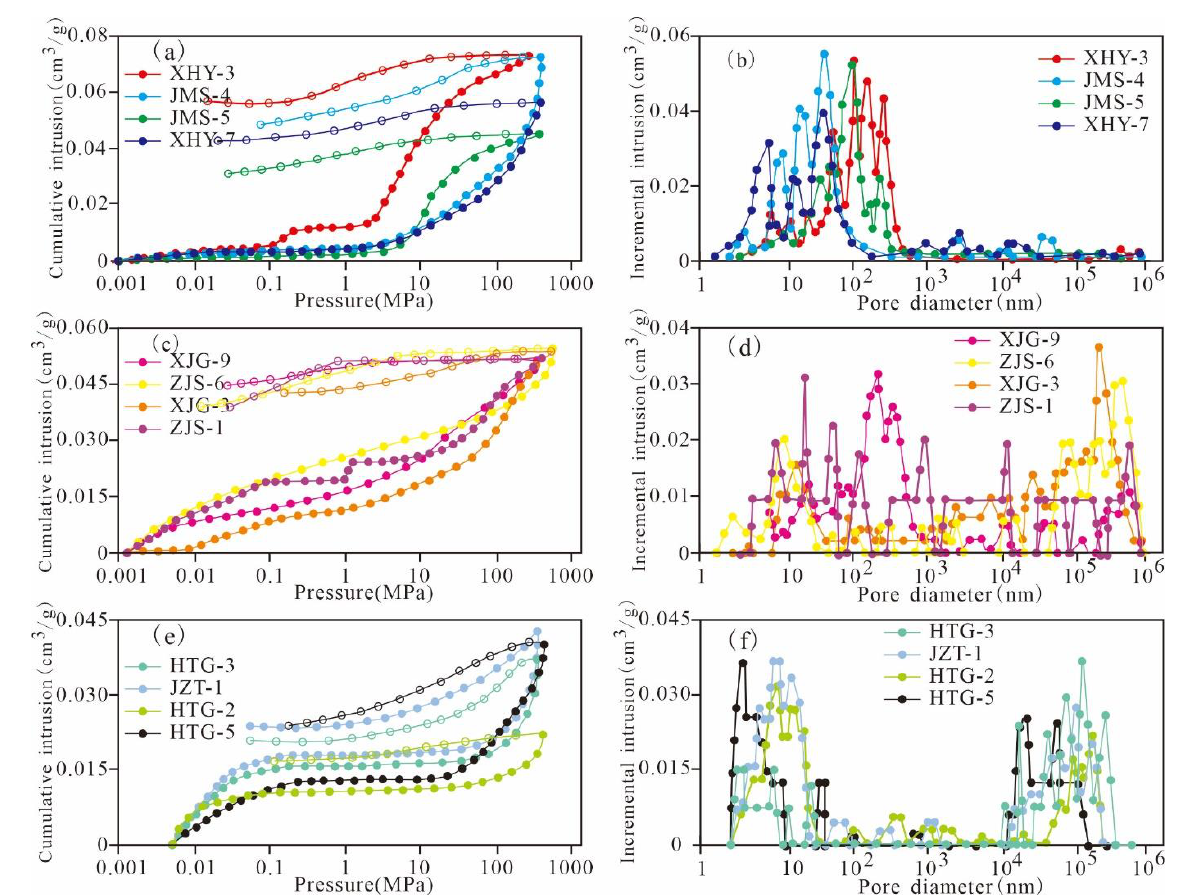
Figure 2. Mercury intrusion curve characteristics and pore type classification of Mesoproterozoic Xiamaling shale samples in Zhangjiakou, Hebei.4.3. Mesopore and micropore characterization based on gas adsorption. ( a , b ): the first type of MIP curve and its corresponding pores; ( c , d ): the second type of MIP curve and its corresponding pores; ( e , f ): the third type of MIP curve and its corresponding pores).